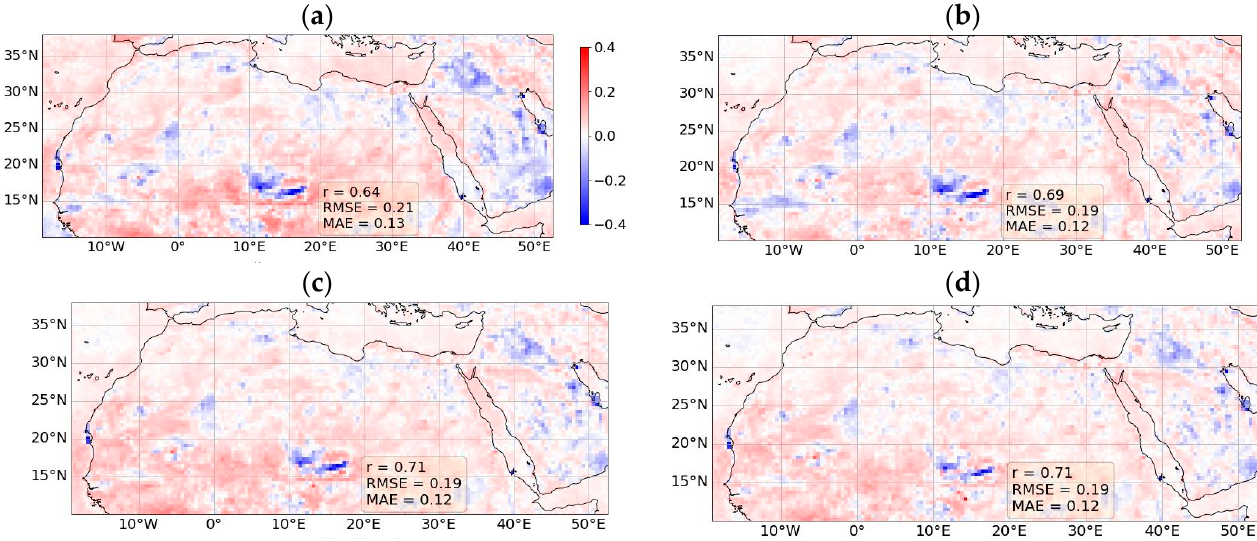
Figure 11. Median values of the difference between CHIMERE bias corrected AOD 550 and MODIS AOD 550 for the dates of D Test for the ( a ) MLR, ( b ) NN, ( c ) RF, and ( d ) XGB ML models.